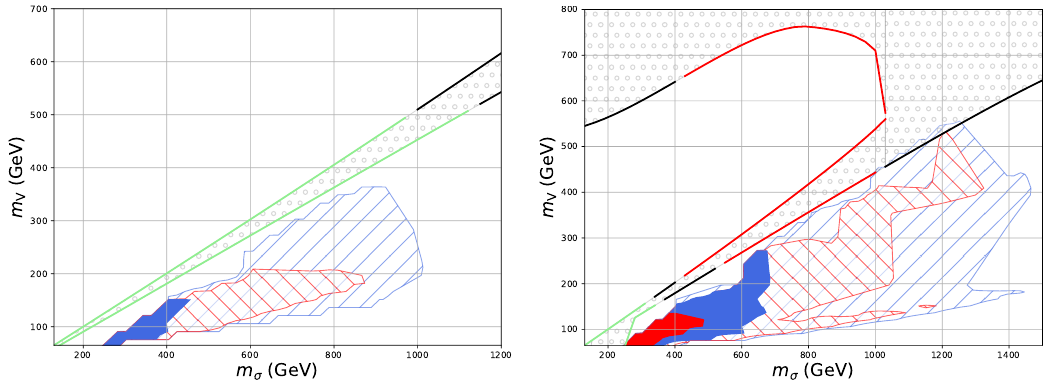
Figure 7 . Combined dark matter, Higgs and collider constraints on the considered model for sin (cid:11) = 0 : 11 (left) and 0.15 (right) in the ‘magic window’ where f = v= tan (cid:11) and under the assumption of a ‘minimal Higgs-dilaton mixing’ treatment. The solid lines show the curves where the dark matter density matches the Planck limit of (cid:10) h 2 = 0 : 12 with the circular shading between them showing the underdense regions. The solid line is green and orange for allowed and excluded by heavy Higgs searches, and black when excluded by dark matter direct detection. The solid and hatched regions show the current and future exclusions from dark matter collider searches: the solid blue region is the future exclusion reach at the HL-LHC after accounting for LO signal cross sections and the hatched blue region is the same constraint but with the signal enhanced by 2 (cid:27) according to the uncertainty on its total rate. The red solid and hatched region represent the corresponding constraints at the end of the LHC run 2.